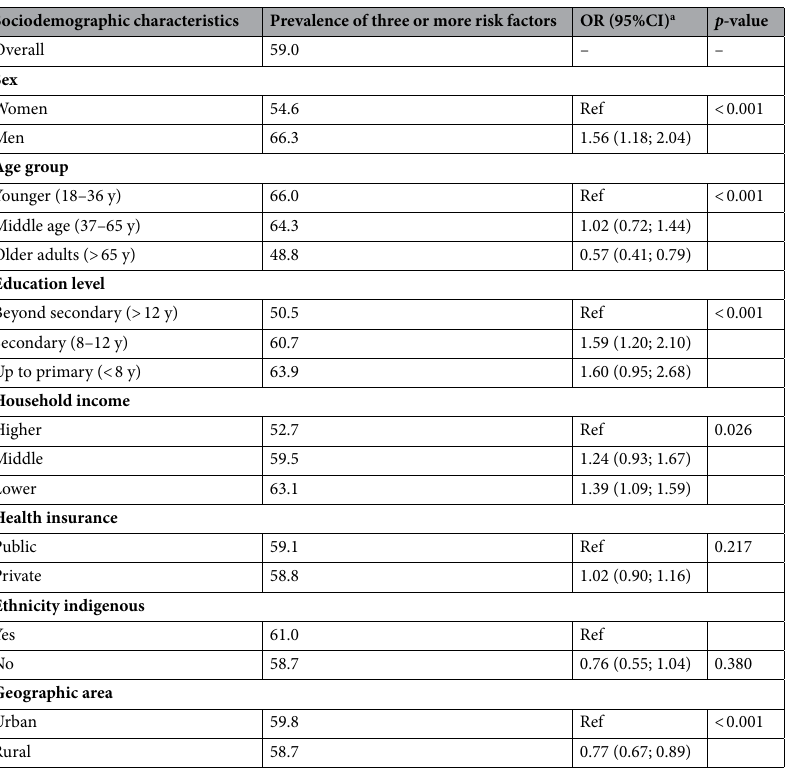
Table 3. Multivarible logistic regression models (OR [95%CI]) for sociodemographic characteristics with co-occurrence of three or more risk factors for non-communicable disease in Chilean residents. OR odds ratio, 95% CI confidence interval 95%, Ref reference, y years. a Multivariable logistic regression model with risk factors for non-communicable disease (as dependent variable), adjusted for sex, age, education level, household income, health insurance, ethnicity, and geographic